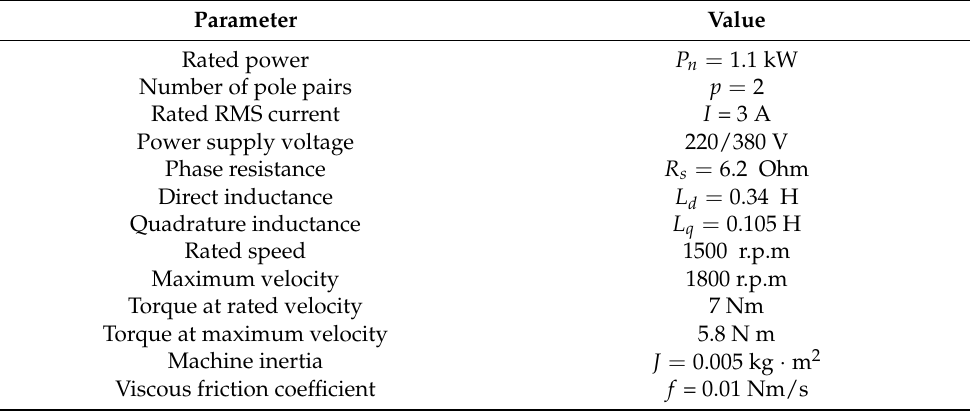
Table A1. The synchronous reluctance machine’s